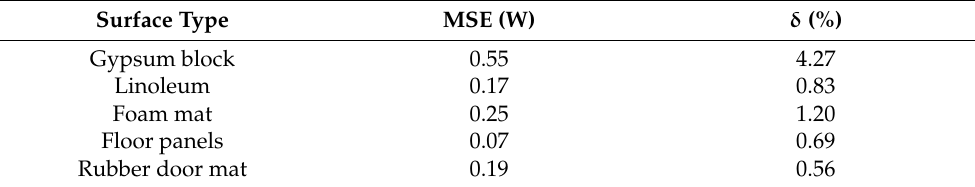
Table 5. The calculated values of quality factors for the neural network of the differential drive